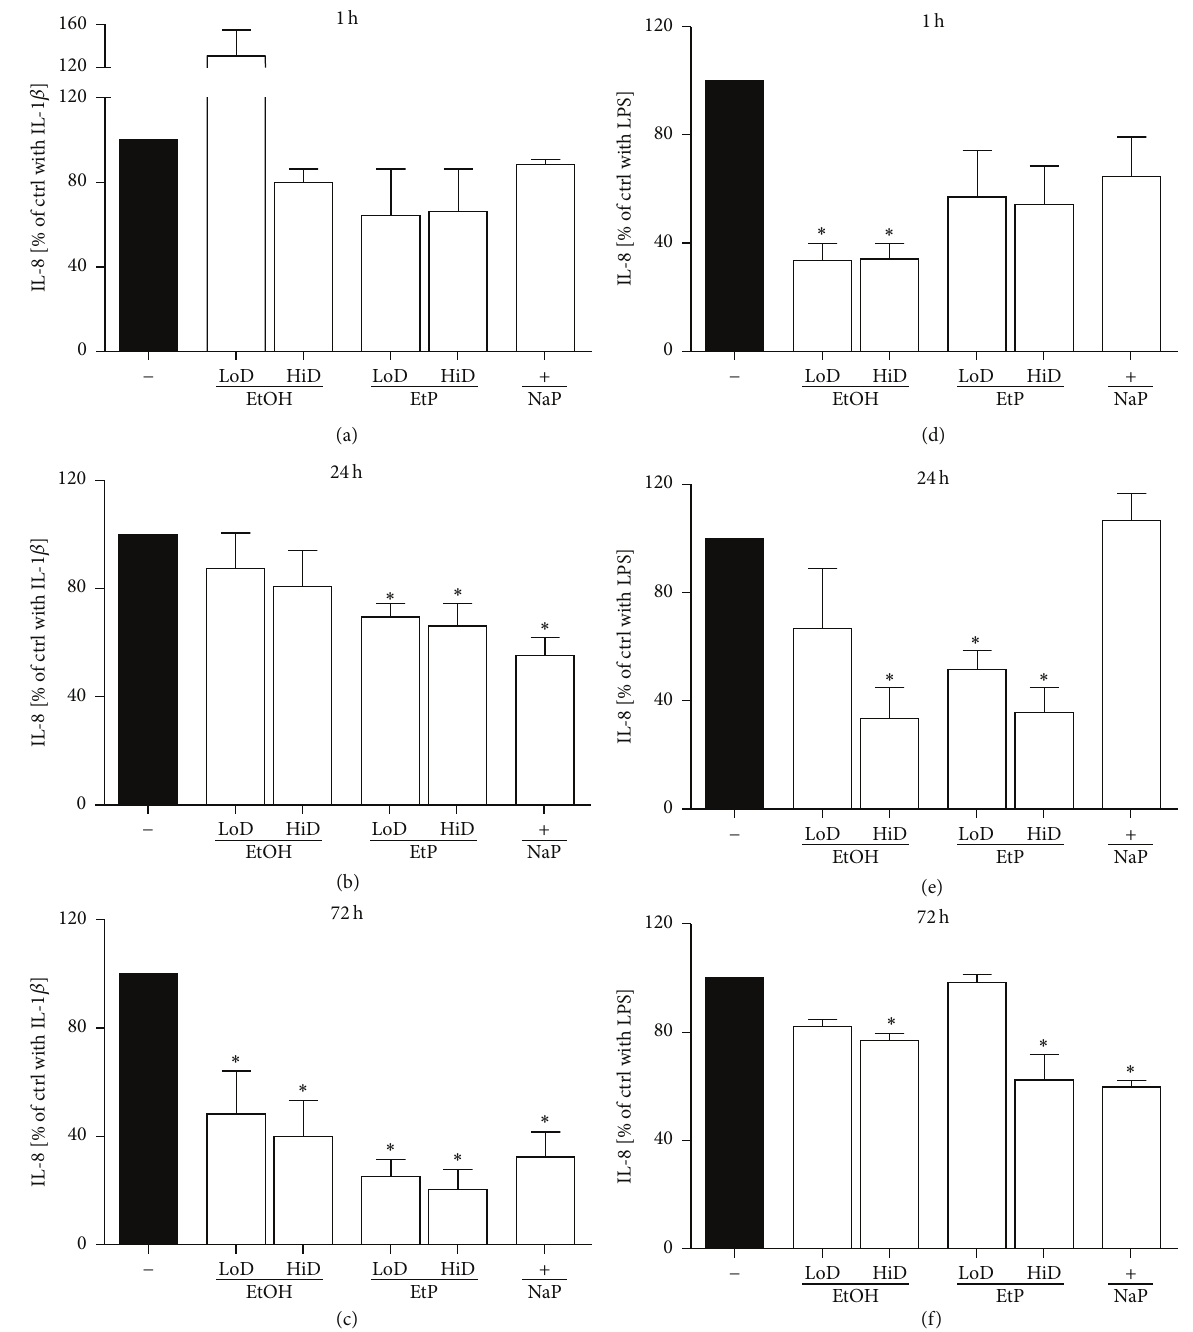
Figure 5: Effects of ethanol (EtOH), ethyl pyruvate (EtP), or sodium pyruvate (NaP) on interleukin (IL)-8 release from lung epithelial cells A549 after IL-1beta ((a)–(c)) or lipopolysaccharide (LPS (d)–(f)) stimulation. Cells were treated with EtOH (low dose, LoD = 85 mM and high dose, HiD = 170mM), EtP (LoD = 2.5 mM and HiD = 10mM), or NaP (10mM) for 1 h ((a) and (d)), 24 h ((b) and (e)), or 72 h ((c) and (f)) and then stimulated with IL-1beta (1ng/mL) or LPS (1 𝜇 g/mL) for 24 h. After the incubation periods, supernatants were analyzed for IL-8 concentrations (given as % of cells stimulated with agonists only, control, ctrl). The data are presented as means ± s.e.m. ∗ 𝑃 < 0.05 versus ctrl.